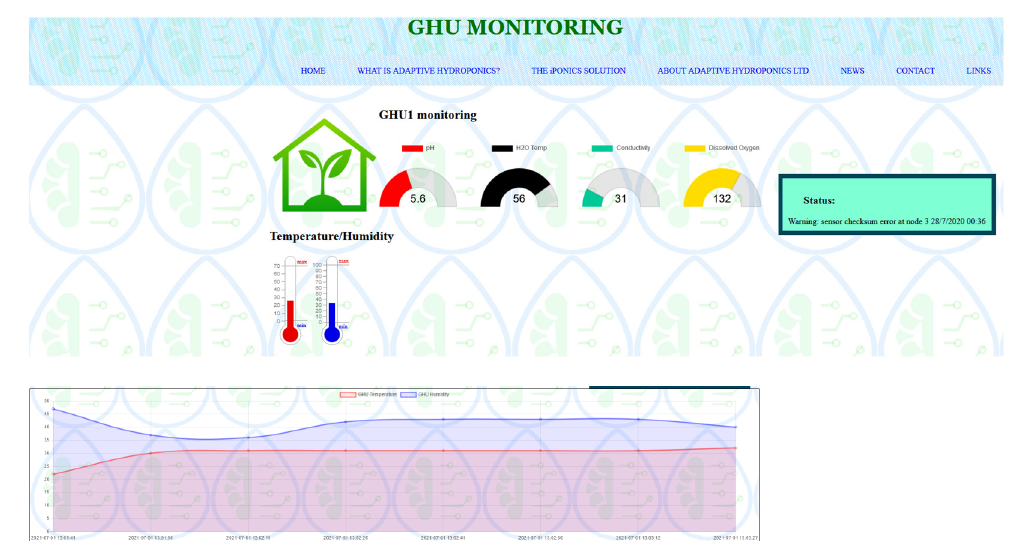
Figure 13. iPONICS monitoring page.